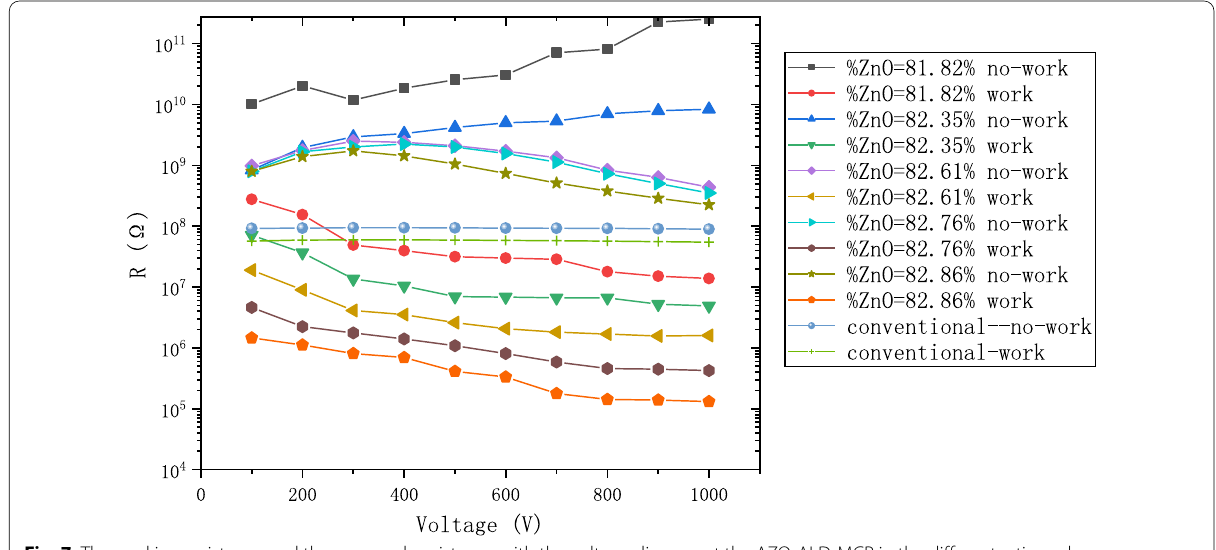
Fig. 7 The working resistance and the non-work resistance with the voltage diagram at the AZO-ALD-MCP in the different ratio and conventional-MCP